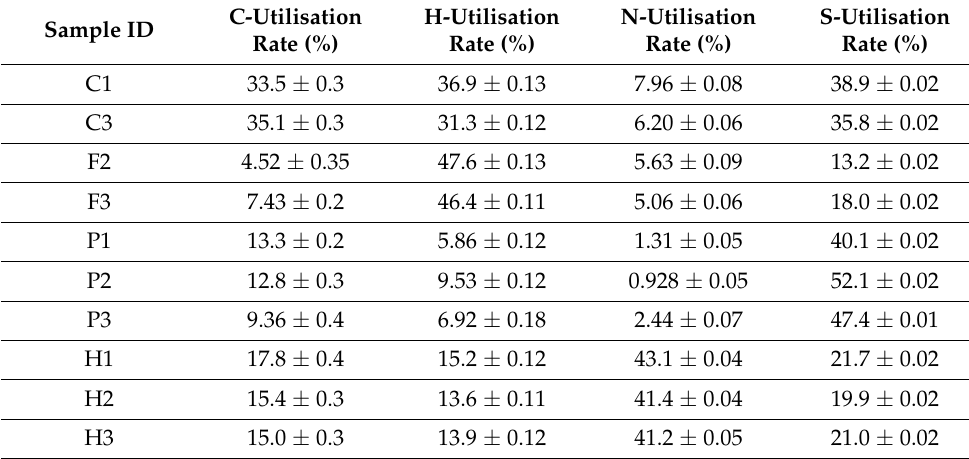
Table 2. Elemental Nutrient Utilisation by Various Animal Species.